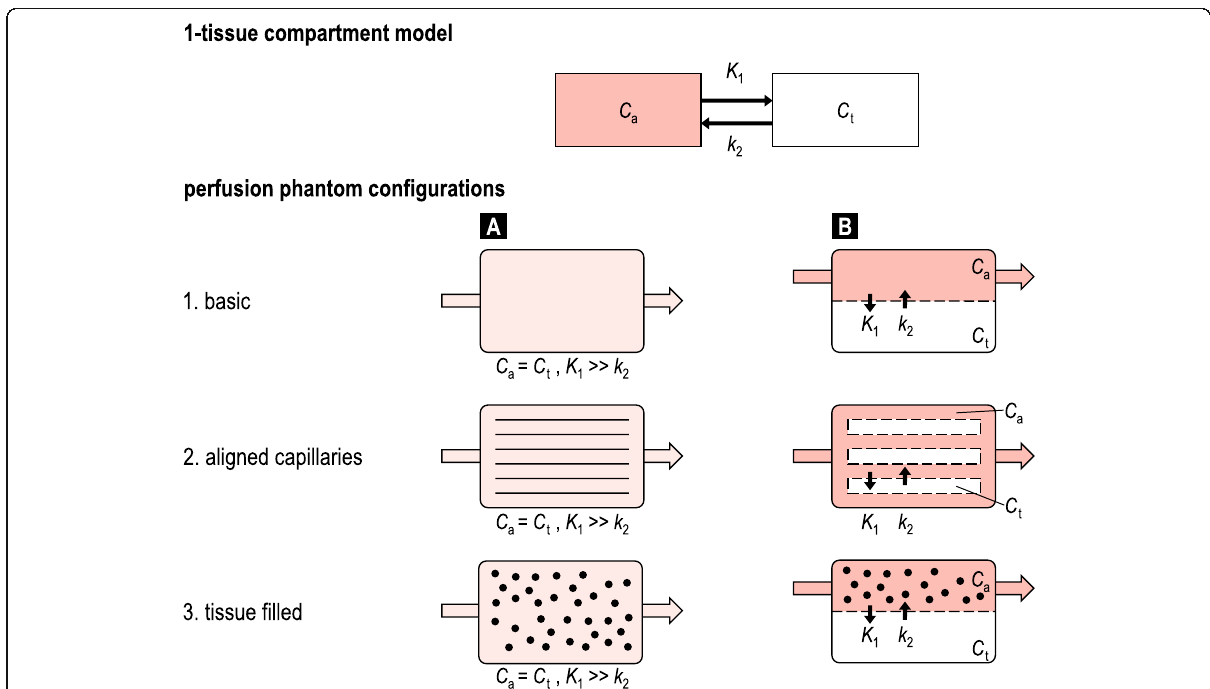
Fig. 3 Schematic representation of the 1-tissue compartment model and six derived phantom configurations. A distinction is made between three phantom types: basic, aligned capillaries and tissue filled (black spheres). Moreover, the microvasculature and tissue can be simulated as one combined ( a ) or two separated volumes ( b ) ( e.g., via a porous membrane). C p and C t represent the concentration of the compound of interest (is being imaged) in the simulated blood plasma and tissue, respectively. K 1 and k 2 comprise the two transfer coefficients. Formation of in- and outgoing flow (arrow) and compartment flow varies per individual phantom